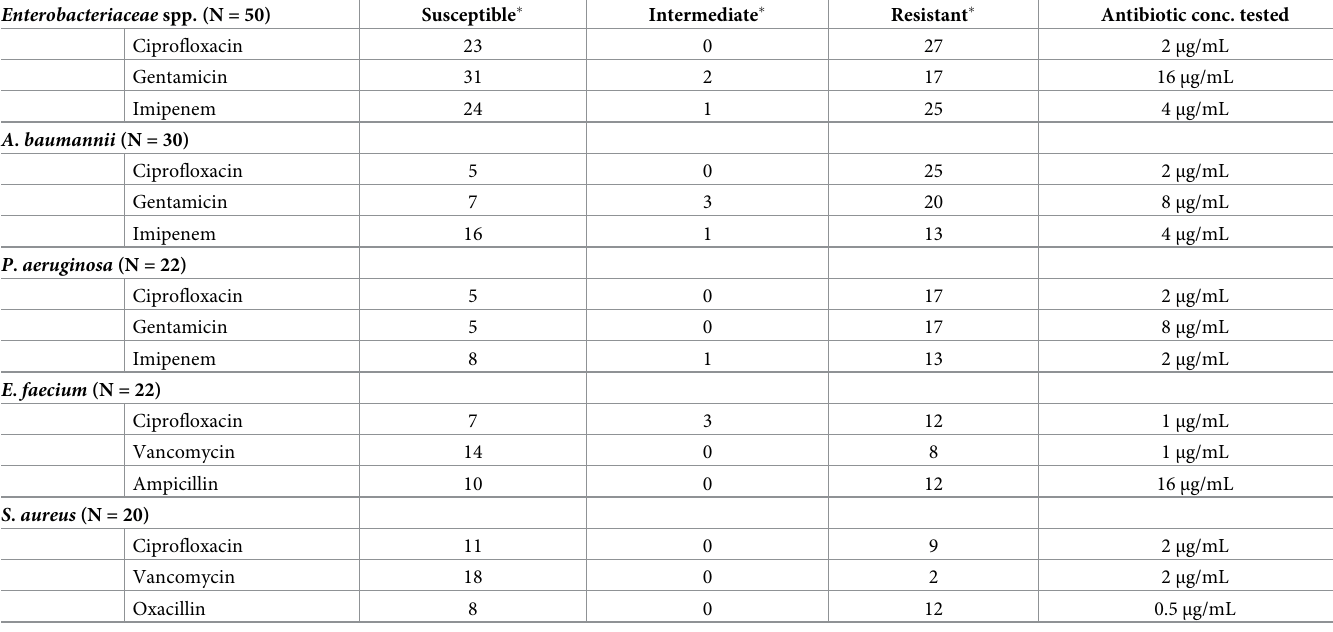
Table 1. Number of tested isolates and the antibiotic concentration used in the qPCR assay.